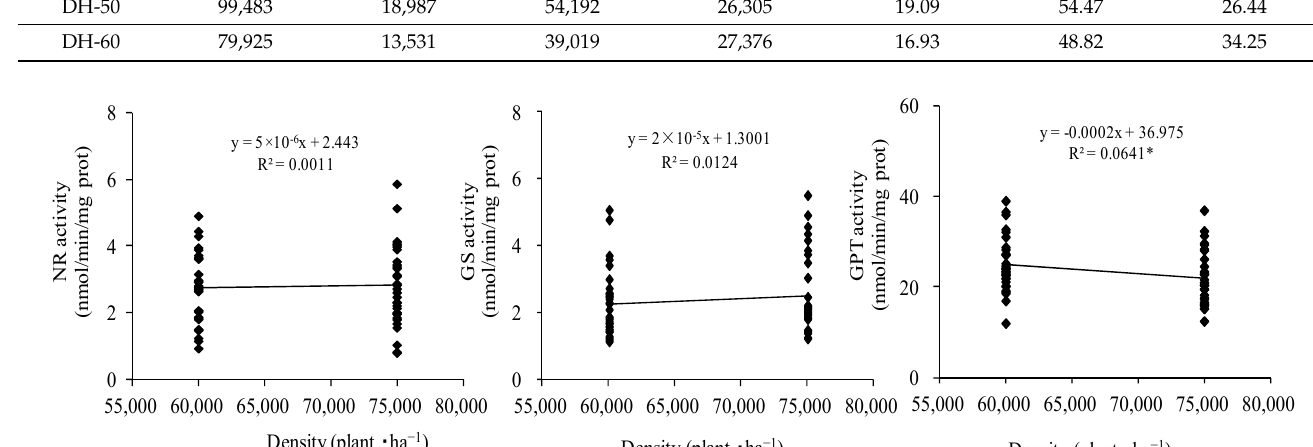
Figure 9. Relationships between plant density and key enzyme activity. Note: “*” indicate a significant correlation at the 0.05 probability level. The dots represent the measured values, and the lines represent the correlation trend in the figure.